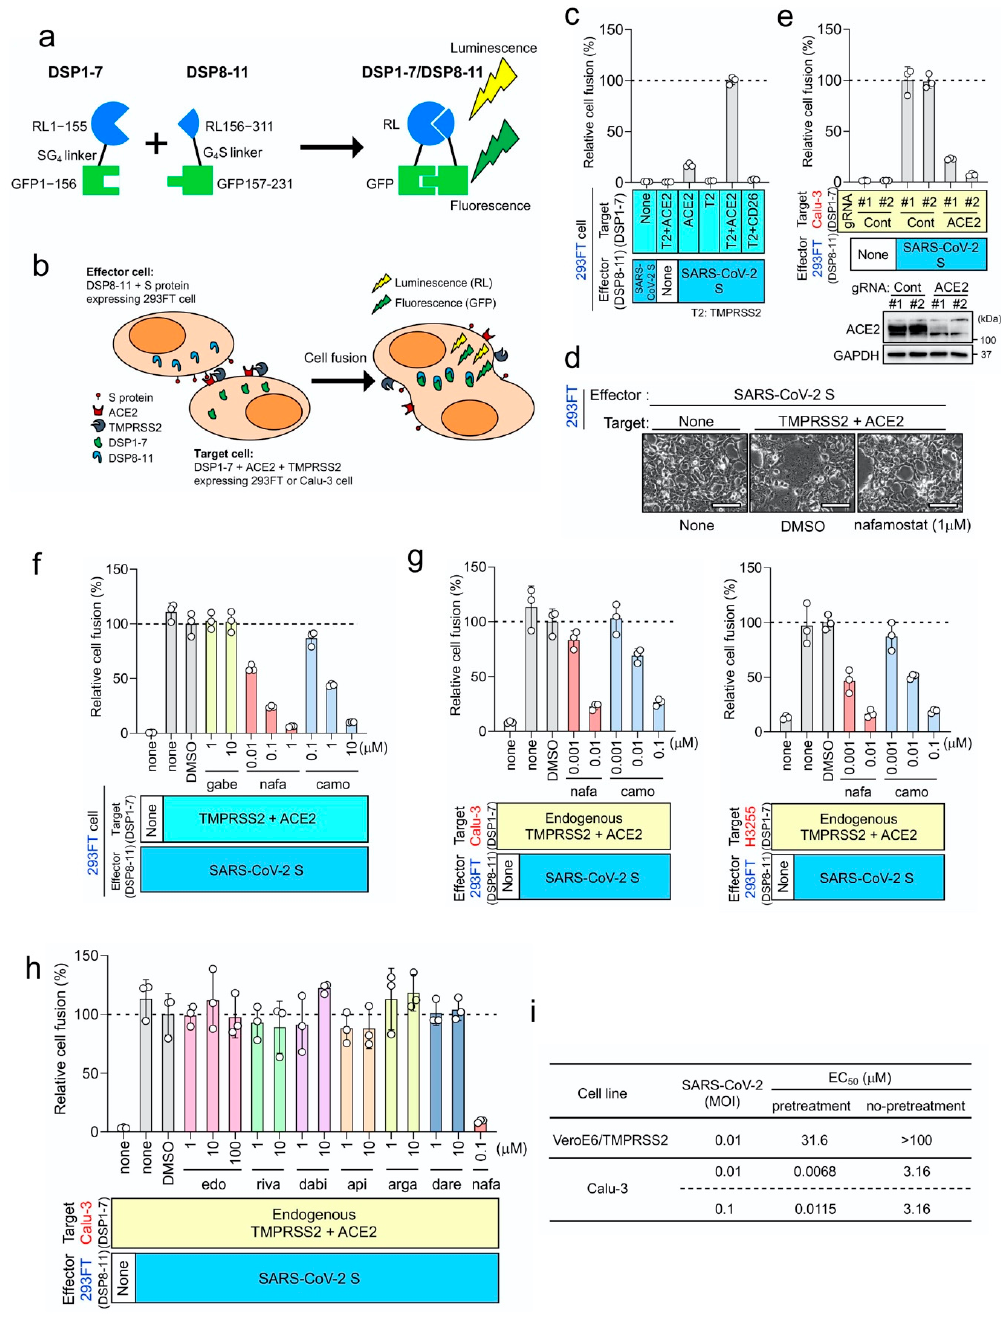
Figure 1. Nafamostat mesylate potently inhibits transmembrane serine protease 2 (TMPRSS2)- dependent severe acute respiratory syndrome coronavirus 2 (SARS-CoV-2) entry into lung epithelium-derived Calu-3 cells. (a) Dual split protein (DSP)1-7 has the structure Renilla luciferase (RL)1 – 155-Ser-Gly-Gly-Gly-Gly-green fluorescent protein (GFP)1 – 156. DSP8-11 has the structure Met-RL156 – 311-Gly-Gly-Gly-Gly-Ser-GFP157 – 231. DSP1-7 and DSP8-11 reassociate efficiently, resulting in reconstitution of functional RL and GFP to generate luminescent and fluorescent signals, respectively. (b) Effector cells (293FT cells expressing DSP8-11 and S protein) and target cells (293FT or Calu-3 cells expressing DSP1-7, angiotensin I converting enzyme 2 (ACE2) and TMPRSS2) were co- cultured. Both GFP (fluorescence) and RL (luminescence) signals were generated following DSP1-7 and DSP8-11 reassociation upon cell fusion. (c) Different combinations of the effector and target cells were cocultured, and the resulting RL activity was measured. Relative cell-fusion values were calculated by normalizing the RL activity of each co-culture to that of the co-culture of cells expressing S protein with those expressing both receptor and TMPRSS2, which was set to 100%. (d) Phase